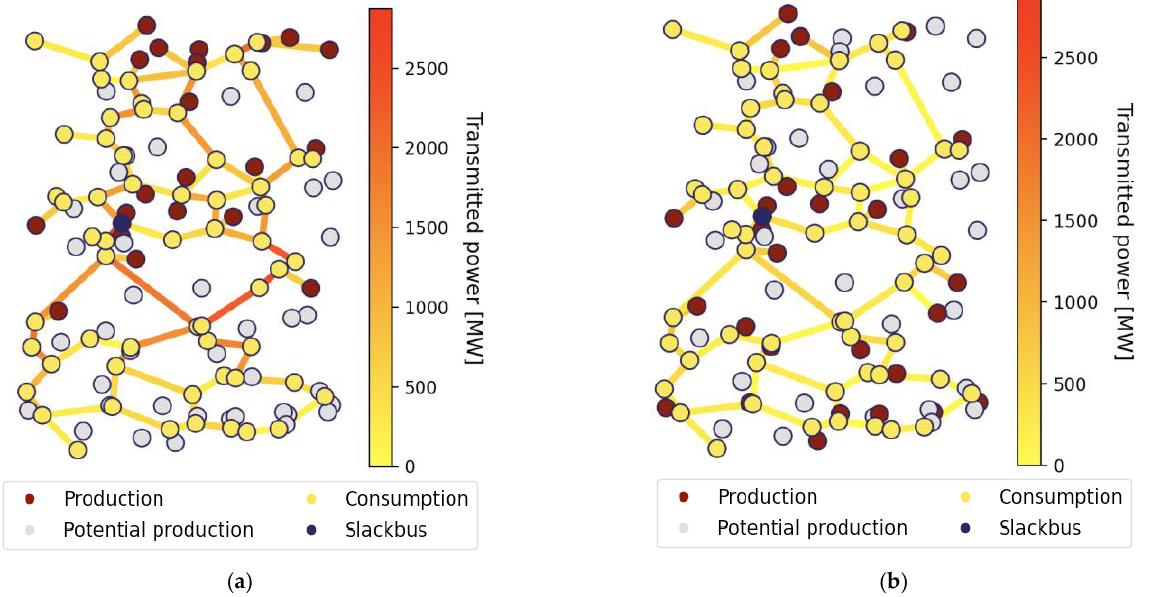
Figure 2. Wind production scenario with a rectangular map area: ( a ) With the base case; ( b ) Reference case when the distance-based value loss was 20%/1000 km.